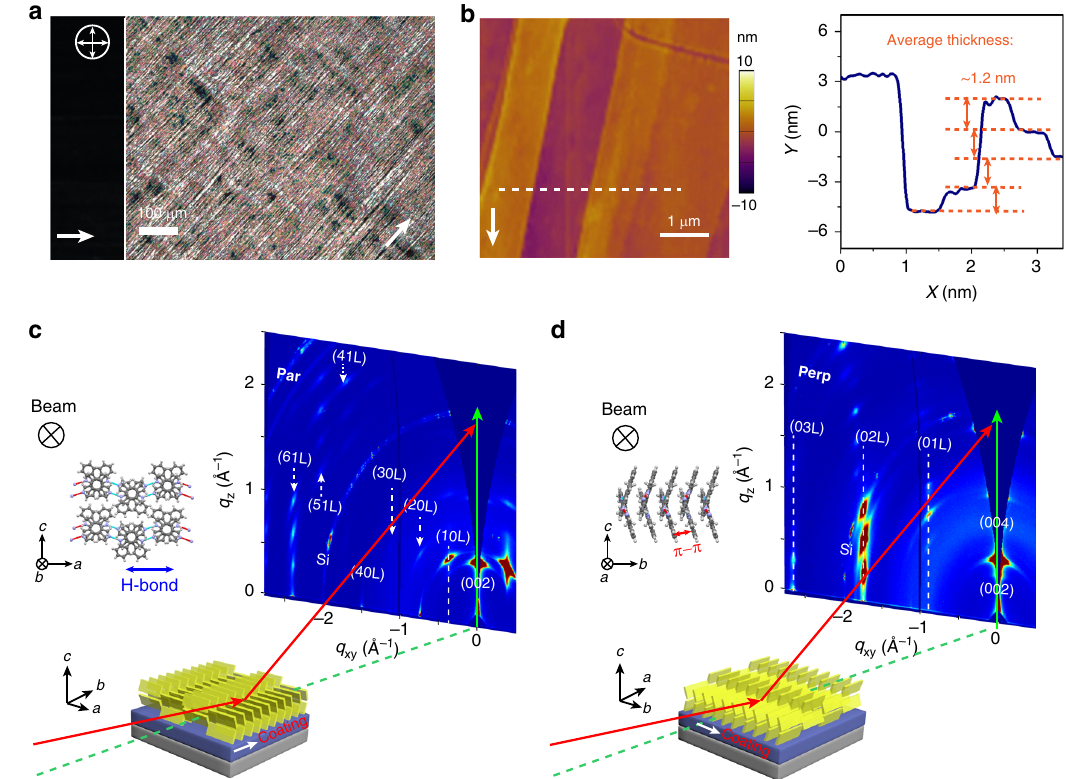
Fig. 4 Structural characterizations of ellipticine thin fi lms. The fi lms were prepared via meniscus-guided coating from its 3mgml − 1 THF solution at 0.05mms − 1 . a Cross-polarized optical microscopy (CPOM) images of ellipticine thin fi lms as deposited (see Methods). b AFM height image and the cross-sectional height pro fi le of the printed thin fi lm along the white dotted line. The step heights are ~1.1 – 1.2nm, comparable to the thickness of a single molecular layer of ellipticine (1.04nm). The white arrows in panel a and b denote the coating direction. c , d Schematic of GIXD experiments and the GIXD patterns. The incident X-ray beam was set c parallel and d perpendicular to the coating direction. The (hkl) miller indices were labeled for corresponding diffraction peaks or Bragg rods. The inset schematic illustrates the inferred orientation of crystalline domains respective to the incident X-ray beam and the coating